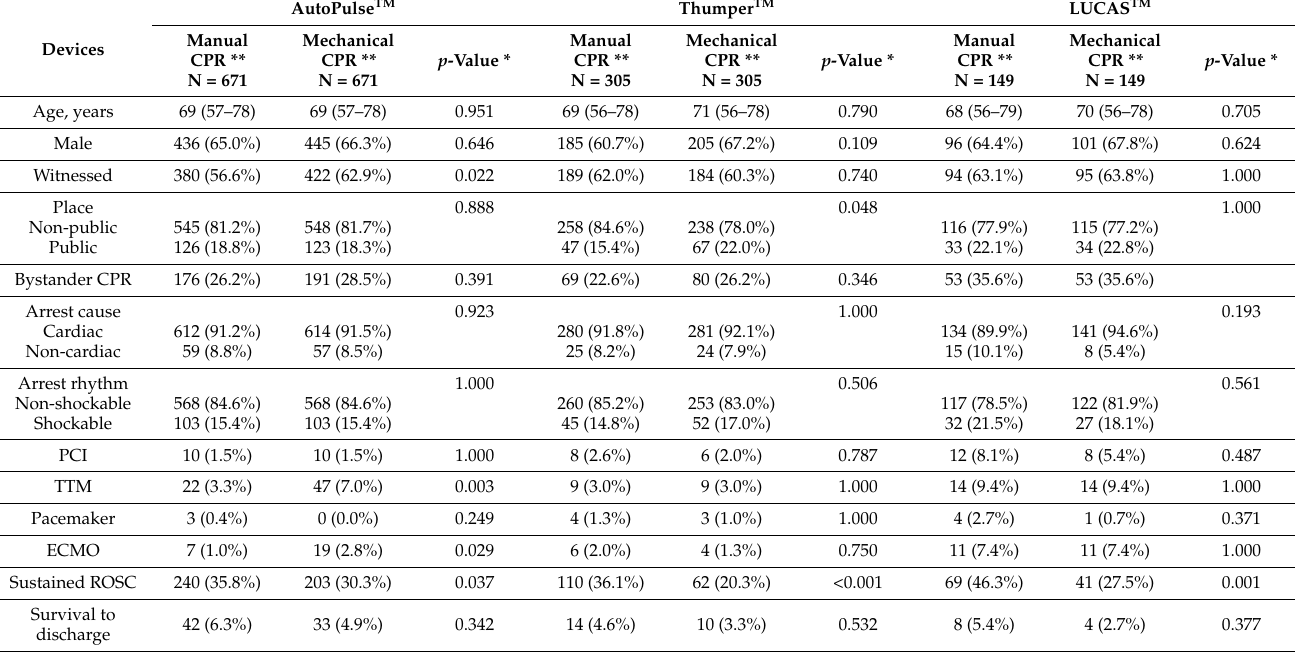
Table 2. Comparison of the compression mechanism in three different mechanical CPR devices after propensity score